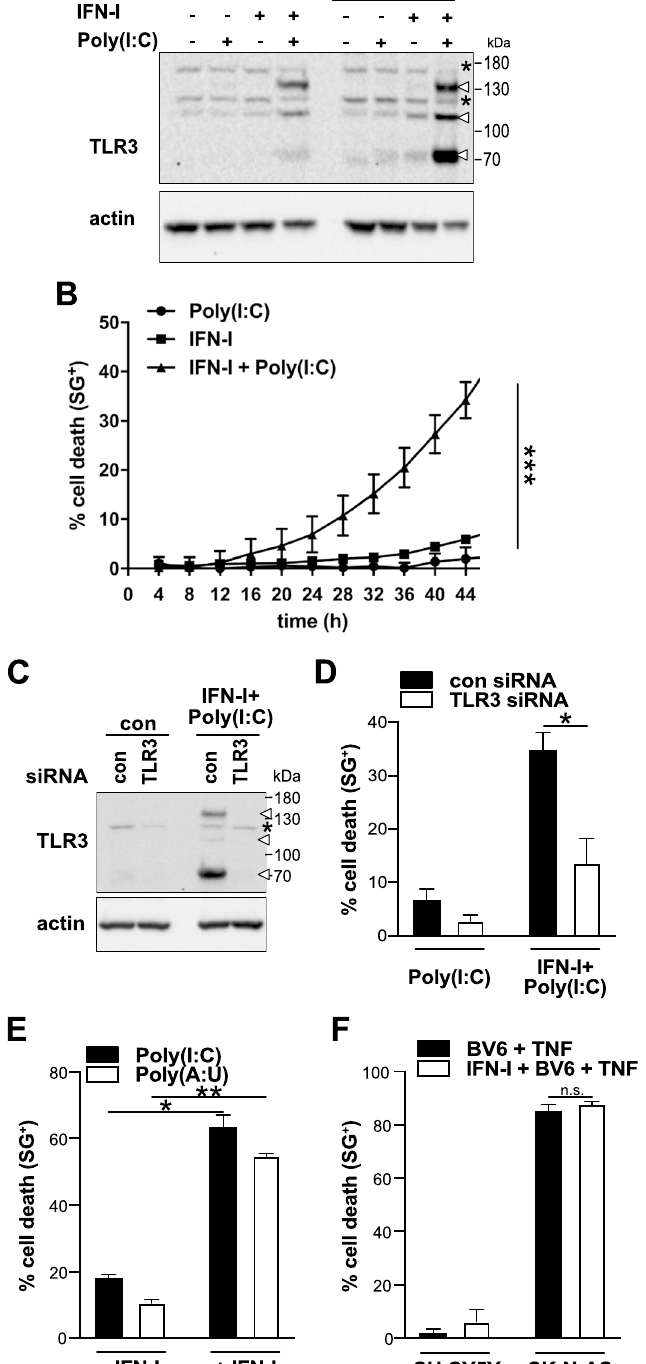
Figure 1. IFN-I/Poly(I:C) treatment induces TLR3-specific cell death in Caspase-8 deficient SH-SY5Y. ( A ) TLR3 expression levels following IFN-I/Poly(I:C) treatment for 24 h and 48 h in SH-SY5Y cells. Asterisks denote unspecific bands. ( B ) Cell death profile of SH-SY5Y cells pre-treated with IFN-I for 16 h prior to Poly(I:C) treatment at the indicated time points. The percentage of SYTOXGreen + (SG + ) cells was analyzed and profiles are expressed as mean ± S.E.M. n (number of independent experiments) = 3; ***p < 0.001. ( C ) TLR3 expression levels of SH-SY5Y cells following siRNA mediated down-regulation of TLR3 and treatment with IFN-I/Poly(I:C). ( D ) Cell death profile of TLR3 siRNA transfected SH-SY5Y cells following IFN-I/ Poly(I:C) treatment for 48 h determined by SYTOXGreen (SG) uptake. Data points represent the mean ± S.E.M of three independent experiment (n = 3); *p < 0.05 ( E ) Cell death profile of SH-SY5Y cells treated with IFN-I/10 μg/mL Poly(I:C) or IFN-I/100 μg/mL Poly(A:U) for 48 h, determined by PI uptake. n = 3; *p < 0.05, **p < 0.01 ( F ) Cell death profile of SH-SY5Y cells treated for 36 h with BV6 + TNF or IFN-I + BV6 + TNF. Cell death was determined by SG positivity. Data points represent 3 independent repeats. ± SEM is indicated. SK-N-AS cells were used as a positive control. n.s. non statistical